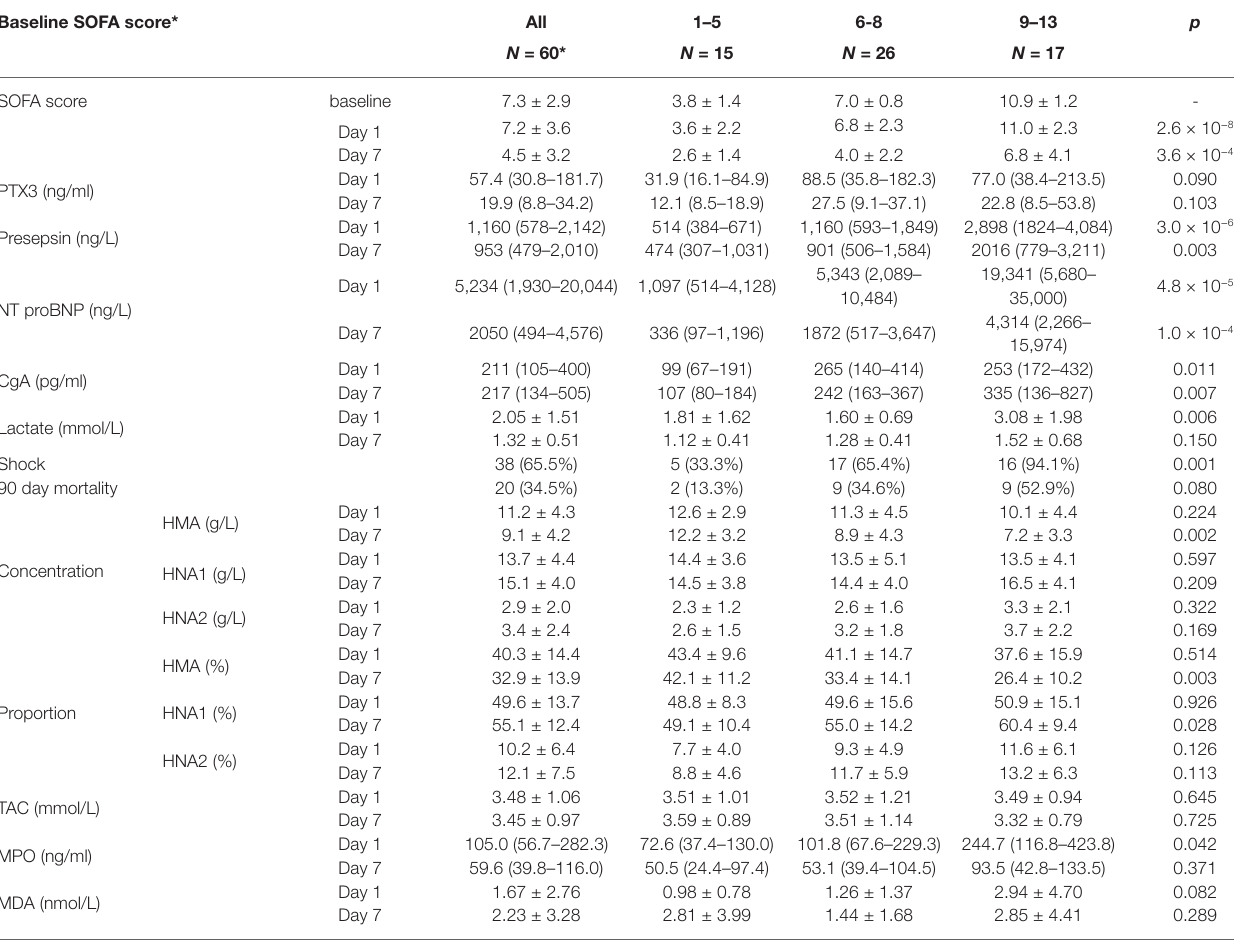
TABLE 3 | Circulating biomarkers and albumin oxidative status by baseline sequential organ failure assessment (SOFA) score. Baseline SOFA